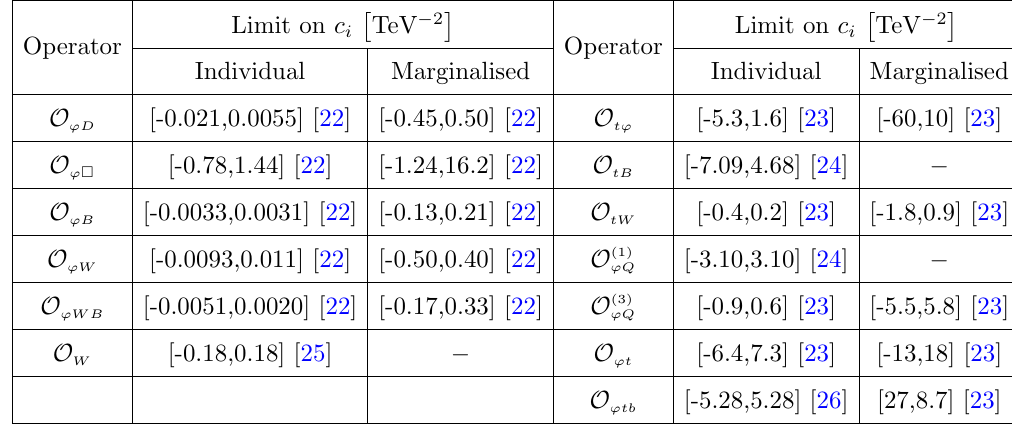
Table 2. Individual and marginalised 95% con(cid:12)dence intervals on Wilson coe(cid:14)cients collected from a selection of global (cid:12)ts to Higgs, top and EW gauge boson data. quark processes such as t (cid:22) t , single top, W helicity fractions and t (cid:22) t + Z=W . One can observe a signi(cid:12)cant hierarchy between the constraints on these two classes of operators in